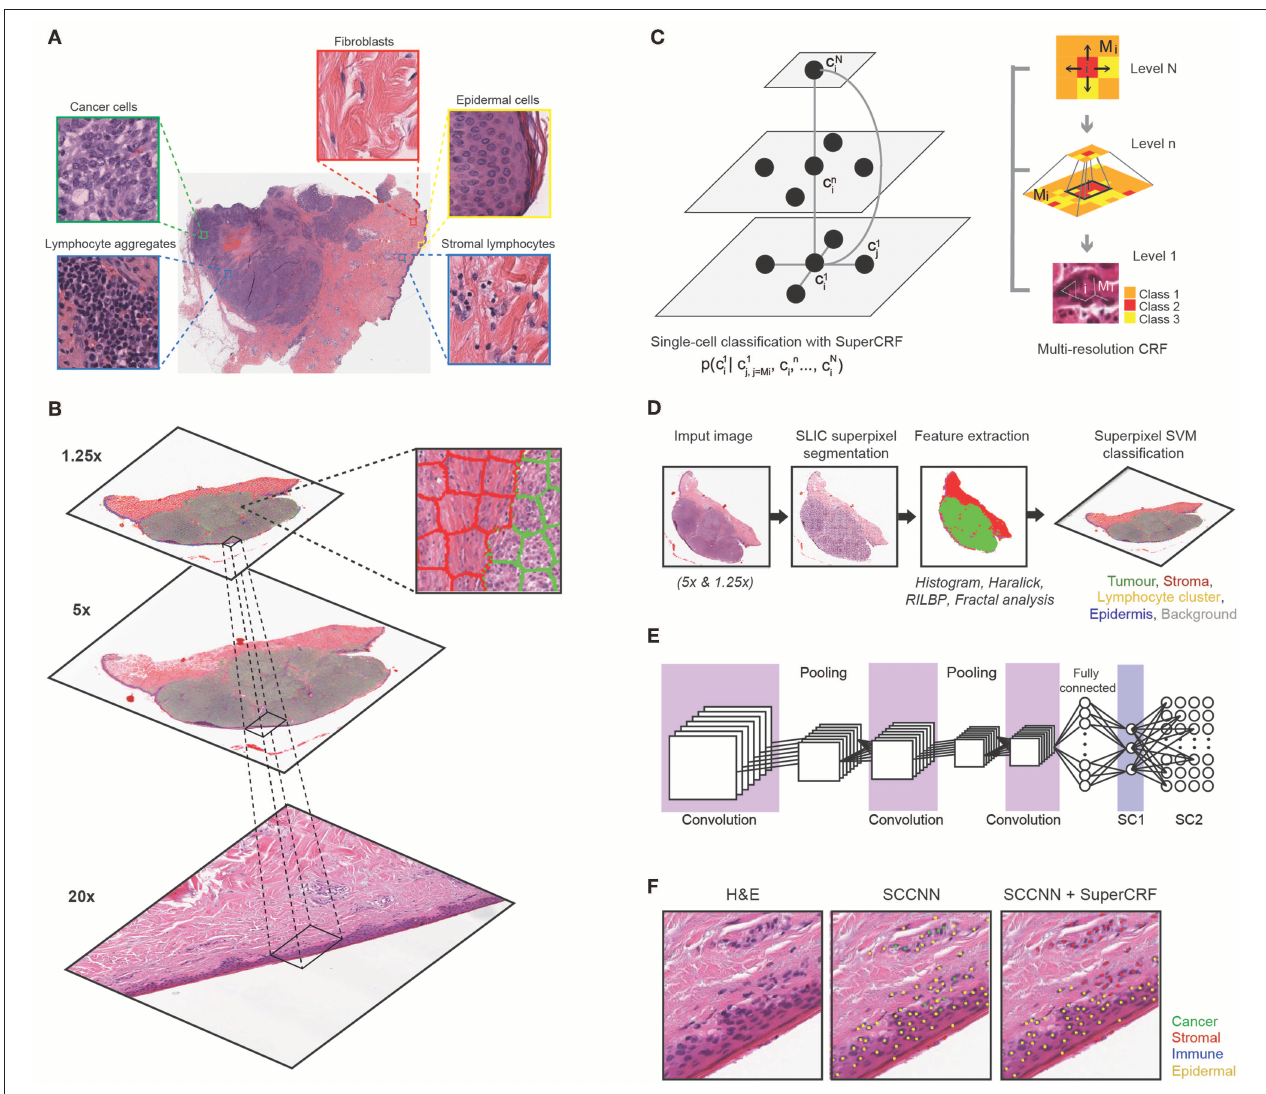
FIGURE 1 | Overview of the SuperCRF framework for analyzing H&E-stained pathological images of melanoma. (A) Major histological features of melanoma architecture. (B) Projection of regional classification results using superpixels from various scales to the 20 × magnification for the improvement of single-cell classification. (C) Graphical representation of node dependencies (cells and superpixels) across different scales. (D) Region classification scheme using a superpixel based machine-learning method in whole-slide images (5 × and 1.25 × magnification) (E) Single-cell classification using a state-of-the-art spatially constrained-convolution neural network (SC-CNN) classifier (F) representative results of the SC-CNN cell classifier alone and combined with our SuperCRF system. Note the misclassification of various stromal cells by the SC-CNN, which are corrected by our